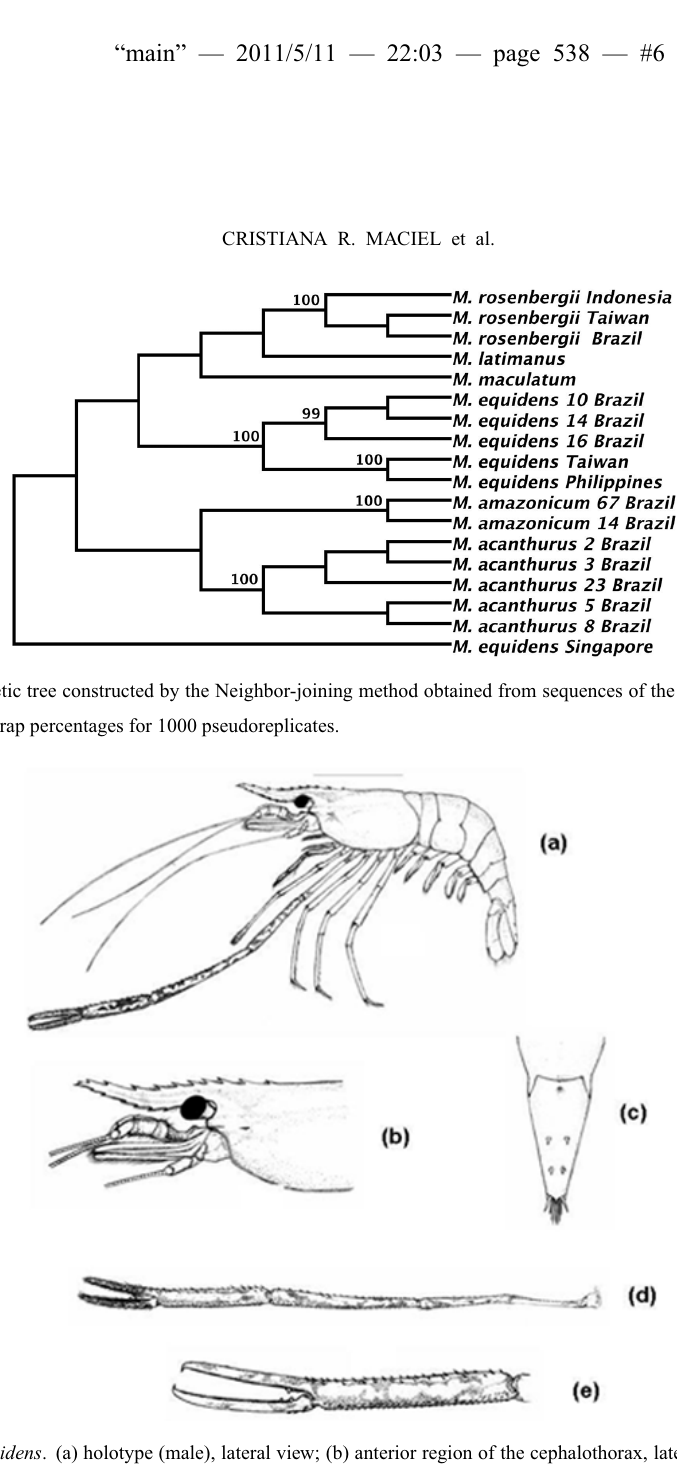
Fig. 3 – Macrobrachium equidens . (a) holotype (male), lateral view; (b) anterior region of the cephalothorax, lateral view; (c) chela (scale 11.4 mm); (d) chela (scale 6.6mm); (e) telson (scale 10